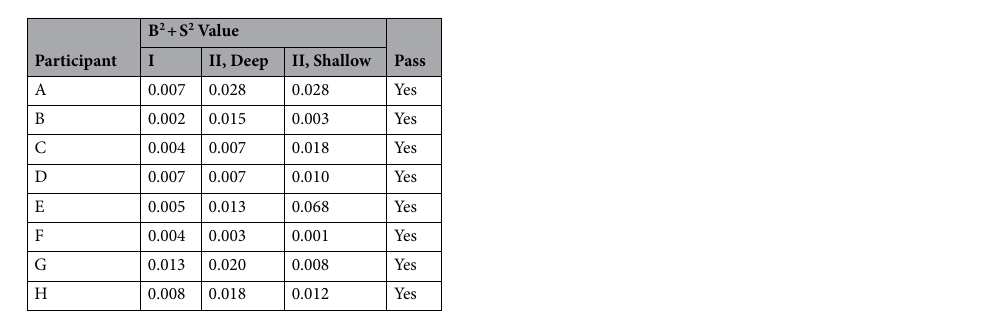
Table 2. The blind test results corresponded to eight dosimetry services, including accidental (category I) and general photon (category II, deep and shallow).